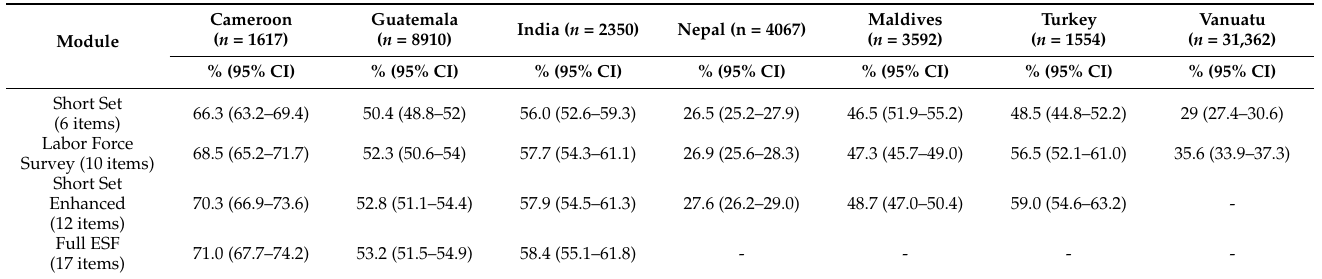
Table 4. Disability prevalence by module type—Wider